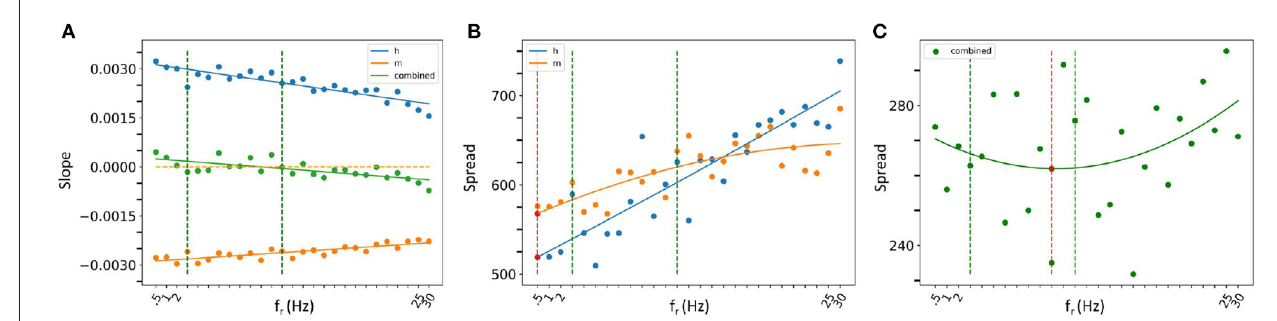
FIGURE8 Spread and slope analysis. (A) Slope analysis. The lines are linear fit lines for Ih alone (blue dots), IM alone (orange dots) or IM and Ih combined (green dots). The orange dashed line is where the slope is zero. (B, C) Spread analysis. The curves are parabolic fits for Ih alone (blue dots), IM alone (orange dots) or IM and Ih combined (green dots) in (C) . The red dashed lines show where the local minima of the parabolic fits are with the minimum shown with a red dot. The theta frequency range (3–12 Hz) is delineated with vertical green dashed lines in all of the